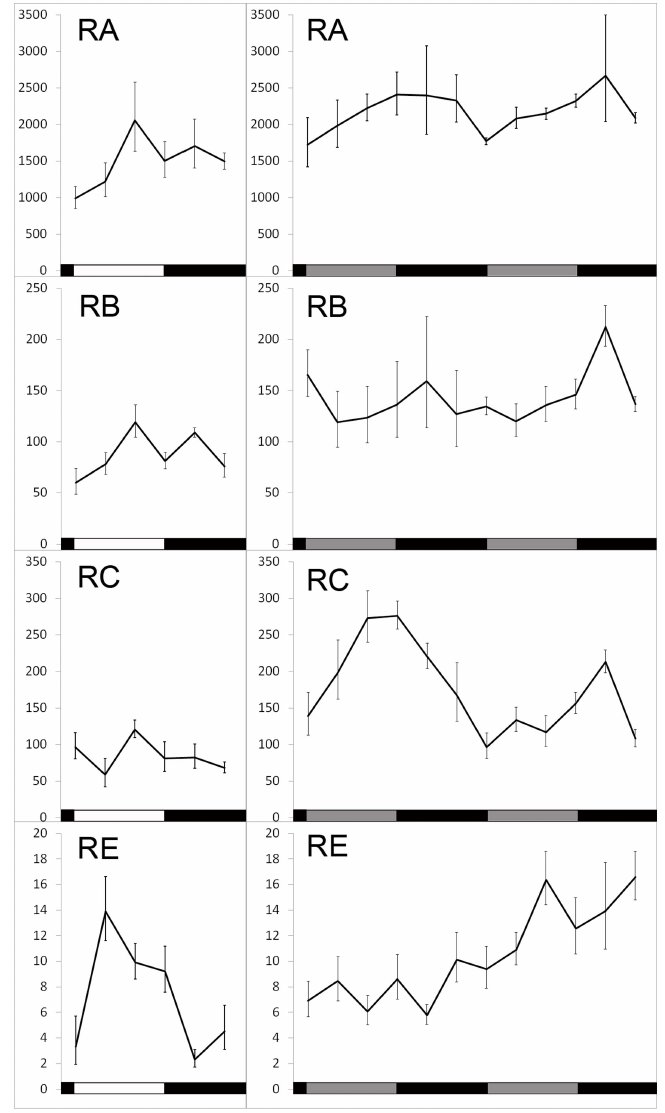
Figure 3. Translation of dbt transcripts in LD 12:12 or constant dark (DD) conditions. Ribosome-bound RNAs were captured by TRAP at indicated Zeitgeber or circadian times and quantified by real-time Q-RT-PCR. Left panel, samples were collected over the course of one day. Right panel, samples were collected during the first and second day of DD. Mean and SEM (error bar) values for at least 6 Q-RT-PCR experiments are shown. One way ANOVA shows a time-dependent change of RC translation in both DD1 (p=0.036) and DD2 (p=0.00028), as well as RE translation in LD (p=0.026).